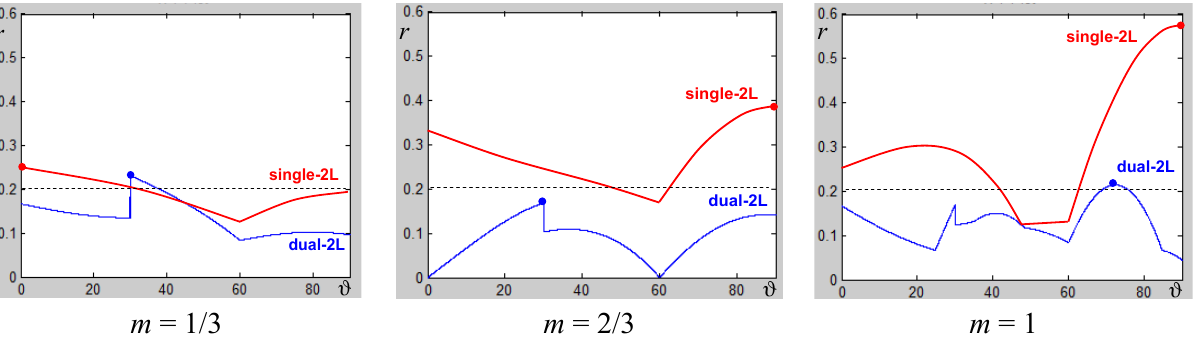
Figure 4. Normalized peak-to-peak current ripple amplitude r ( m , ϑ ) for single- and dual-2L inverters in the range ϑ = [0, 90°] for different modulation indexes.